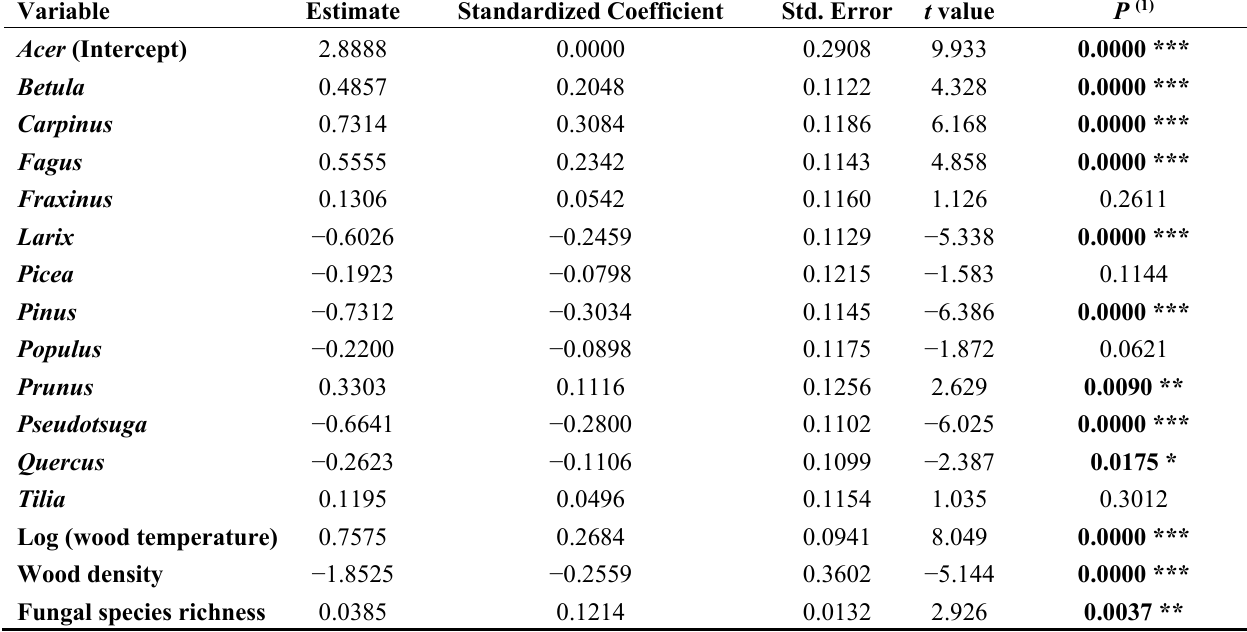
Table 2. Model estimates, standardized coefficients and standard error obtained from the best-fit global linear model with CO 2 emission rates (log transformed) as dependent variable ( n = 355